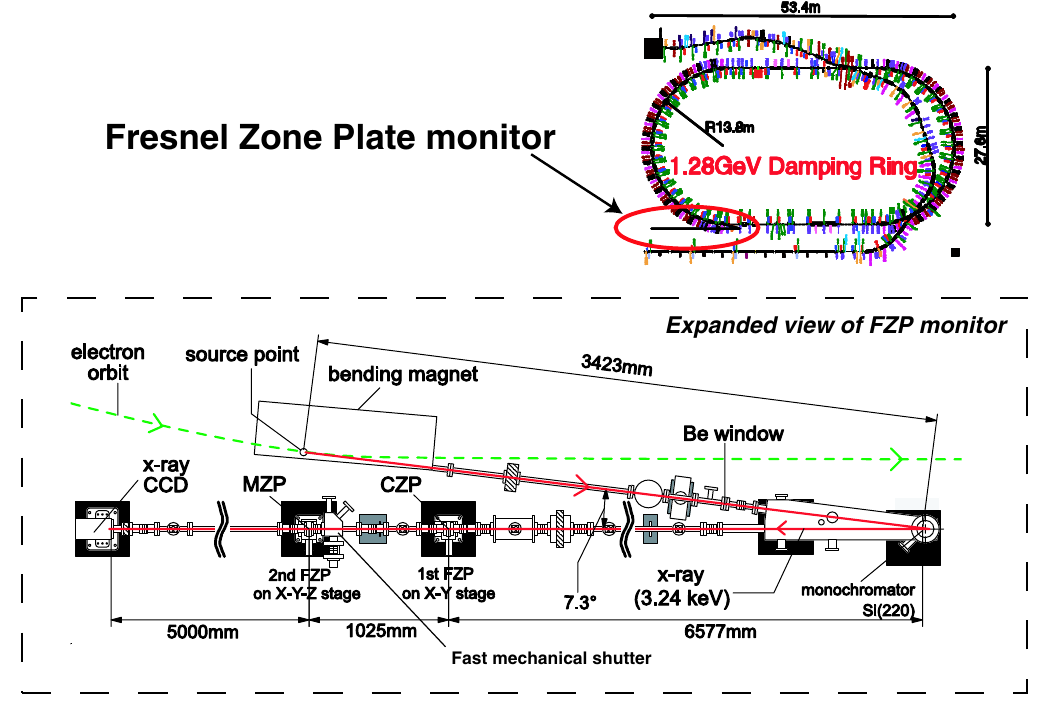
FIG. 2. (Color) Setup of the FZP monitor.